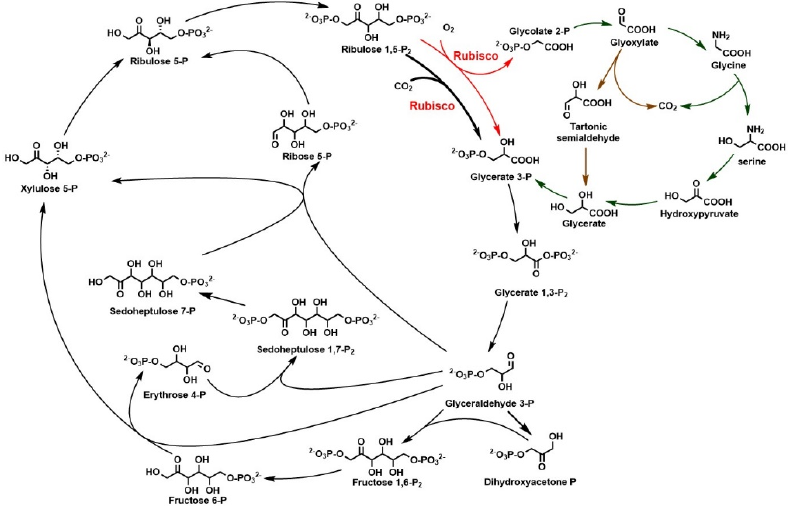
Figure 1. The Calvin–Benson–Basham (reductive pentose phosphate) cycle coupled with phosphoglycolate salvage pathways. The carboxylation step catalyzed by Rubisco is highlighted in bold, and the oxygenation side reaction of Rubisco is indicated in red arrow. The canonical plant photorespiratory pathway is shown in dark green arrow and an alternative phosphoglycolate salvage pathway found in bacteria is displayed (brown arrow) as well.